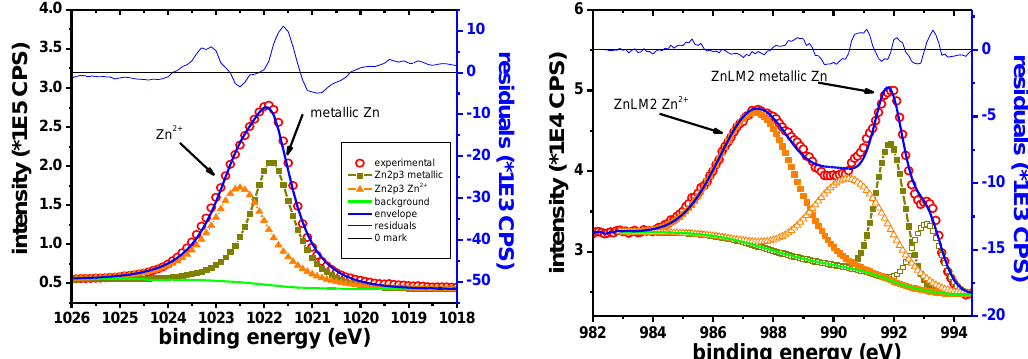
Figure 11. Zn 2p narrow scan ( left ), Zn LMM narrow scan ( right ). Table 10. B.E. and K.E. values for Zn peak contributions/oxidation states. Peak Oxidation State Measured B.E. (eV)